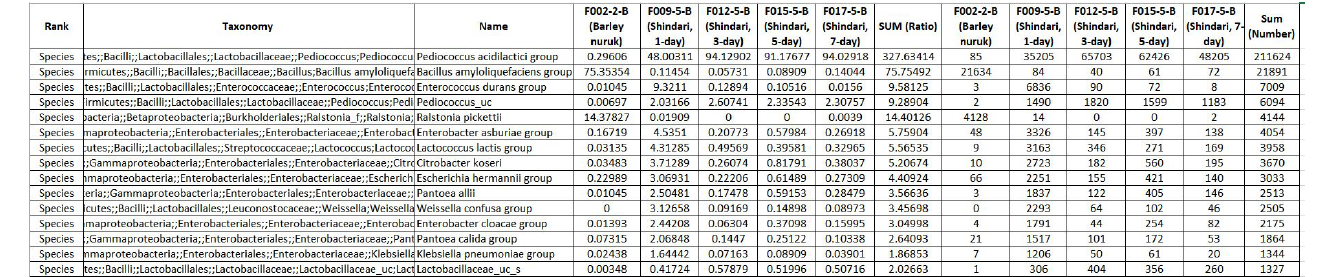
Figure 2. Layout of Shindari microbial community